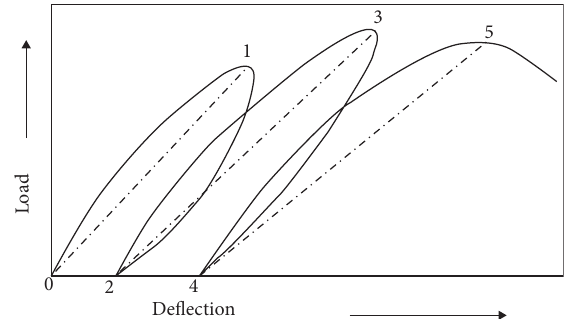
Figure 17: The procedure adopted for determining secant stiffness